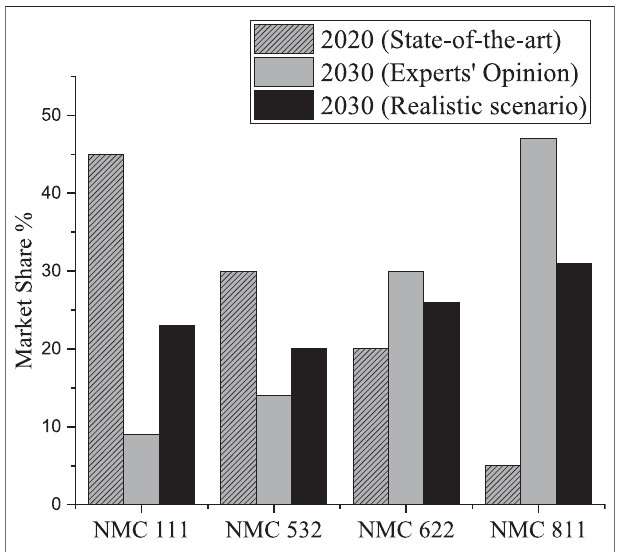
FIGURE 1 | Evolution of NMC Chemistry from 2020 to 2030 and the values according to realistic scenario calculations.